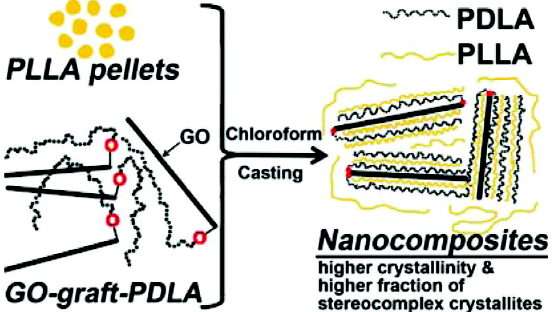
Figure 13. Schematic representation of GO grafting to PDLA and blending in solution for casting stereocomplex homocomposites [69].